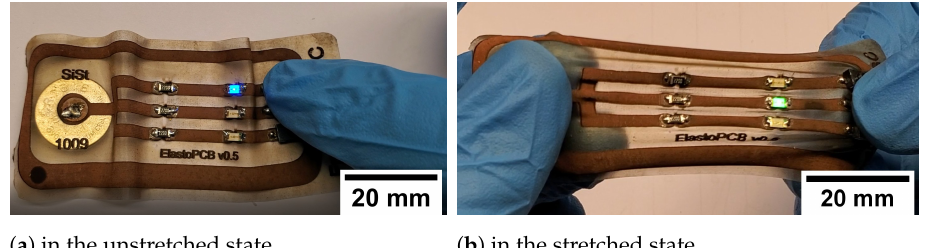
Figure 5. Manufactured circuit board equipped with electrical components in the unstretched state with activated blue LED ( a ) and in the stretched state with activated green LED ( b ). To turn on the LEDs, the respective switches were pressed with the